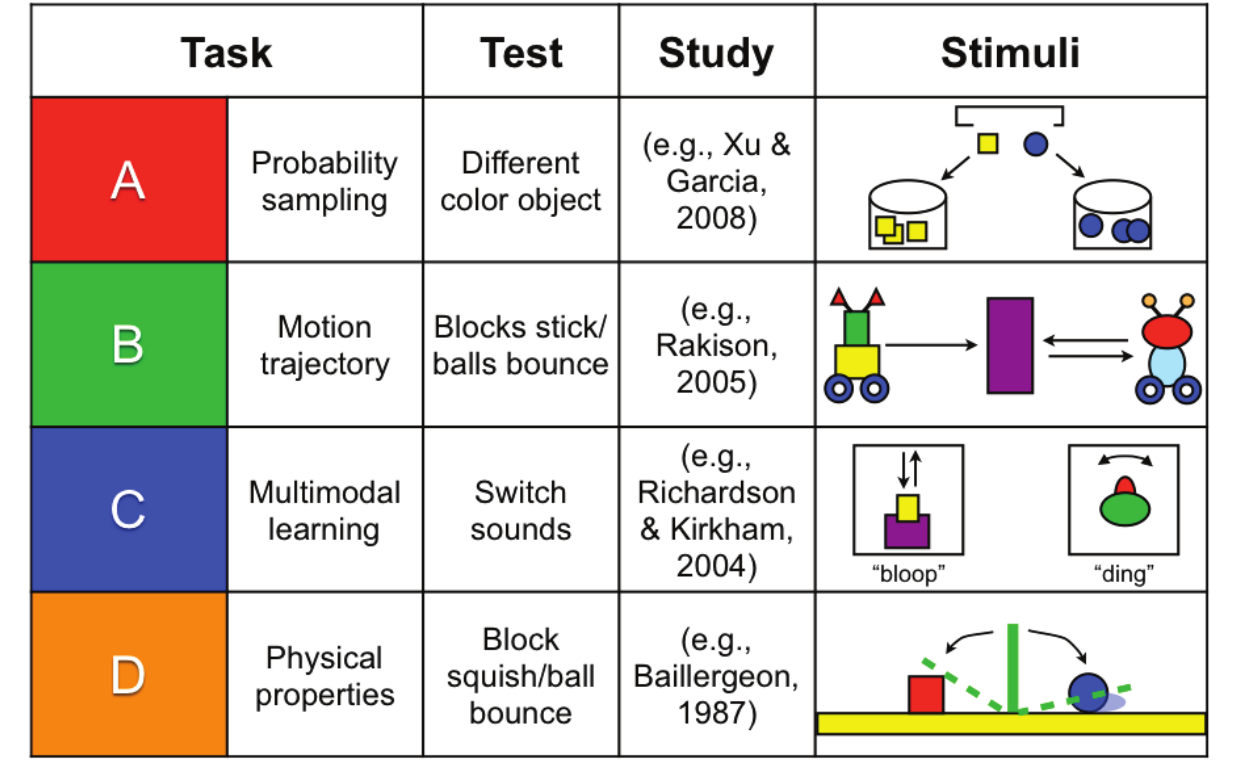
Figure 2 ). The probability sampling task displayed